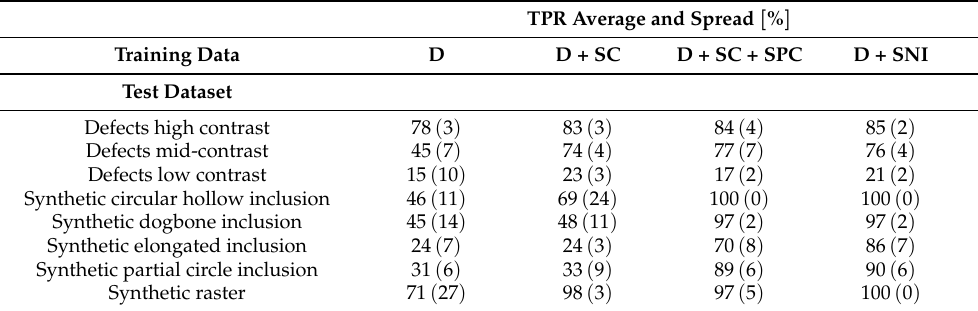
Table 2. Results for the supervised–trained patch-level binary classifier. The TPR is given as the average and the spread ( max − min ) /2 ) within parenthesis, at 0.1% FPR. For the training data, D is for defects, SC is for synthetic circular indication, SPC is for synthetic partial circular inclusion, SNI is for synthetic natural image indications.